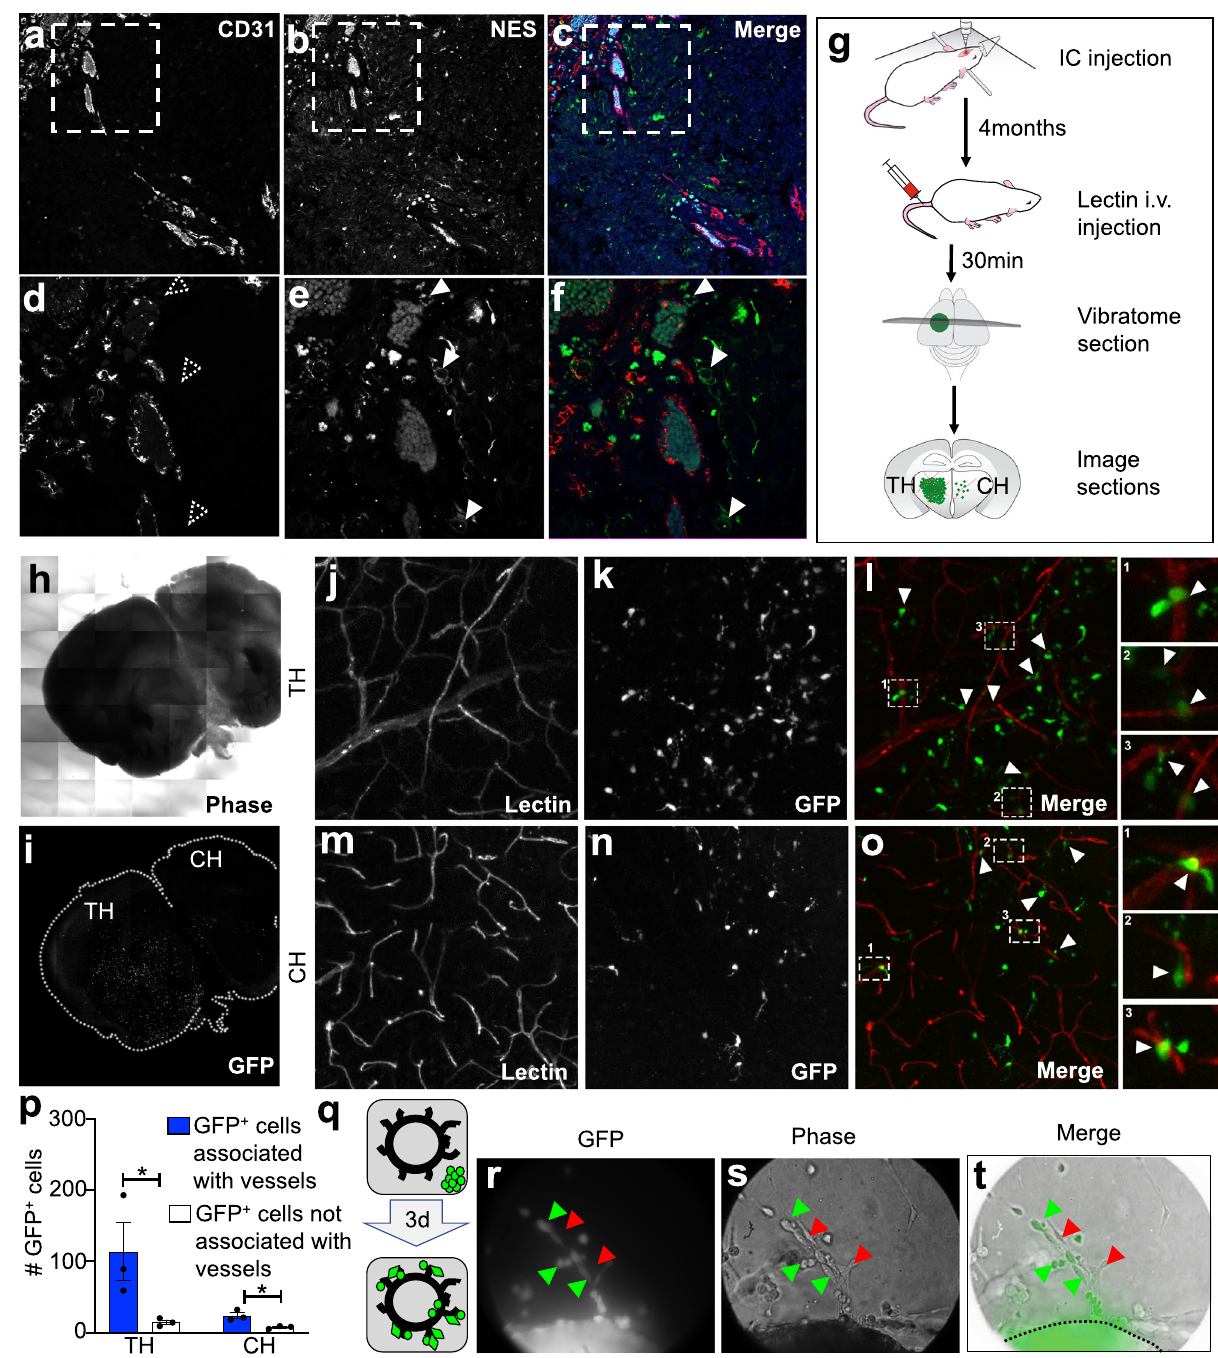
Fig. 1 | Dynamic proximity between glioma stem cells and endothelium. a – f Human GBM tissue co-stained for the endothelial cell (EC) marker, CD31, and forGSCmarker,NES.Whitearrowheadspointto NES + GSCsjuxta-positionedalong CD31 + blood vessels in the GBM tissue. g Schematic of steps taken to obtain live mouse tissues for high resolution confocal imaging of GSCs and ECs in mouse tumor xenografts. Phase tile image ( h ) and Green fl uorescence tile image ( i ) of a vibratome cut 200 µ m thick coronal section of mouse brain injected with GSC157 proneural-GSCs. Lycopersicon lectin-stainedbloodvesselsinthetumorhemisphere (TH; j ) and contralateral hemisphere (CH; m ) of the mouse tumor xenografts. GFP labeledGSC157cellsinthetumorhemisphere( k )and contralateralhemisphere( n ) of the mouse brain. Merged Lycopersicon lectin /GFP with insets showing GSC